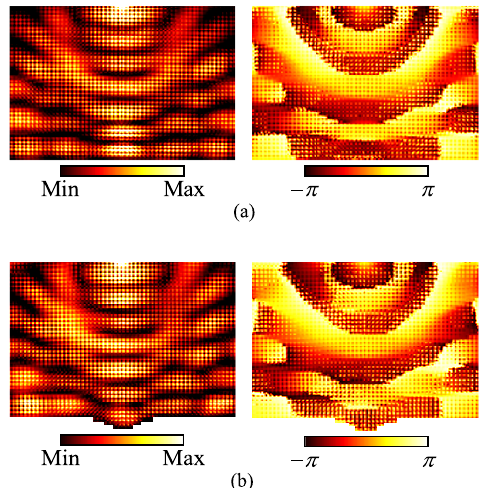
Fig. 20. Measured complex electric near- fi eld distributions with a point source at the top center (Position A in Fig. 19) at 4.65 GHz. Left: Amplitude. Right: Phase. (a) With the groove illusion medium. (b) With the original groove.